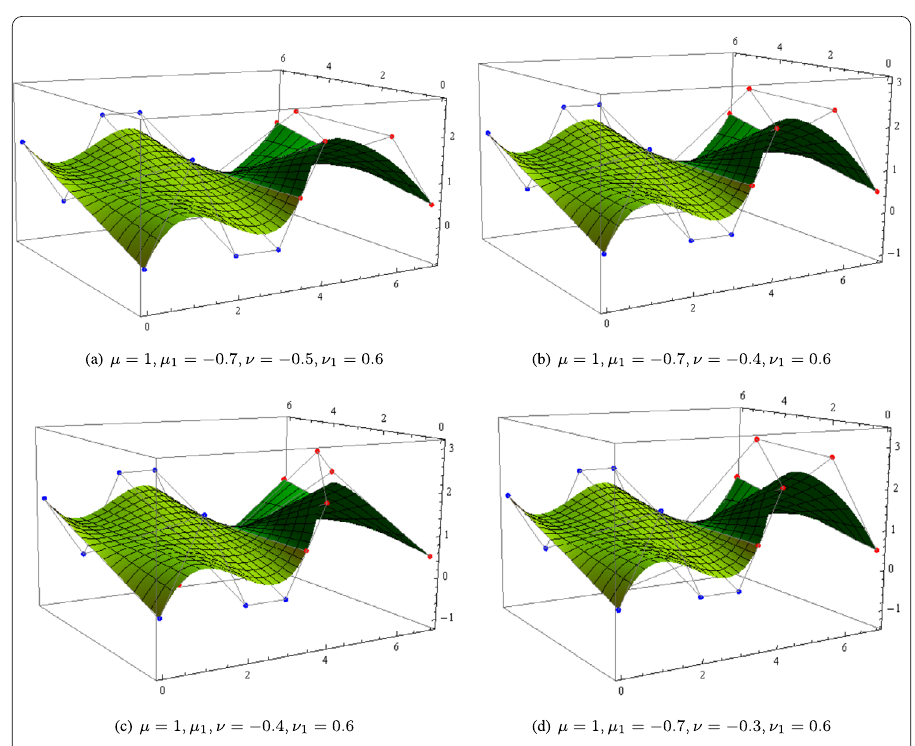
Figure 12 C 3 continuity between two GBT-Bézier ruled